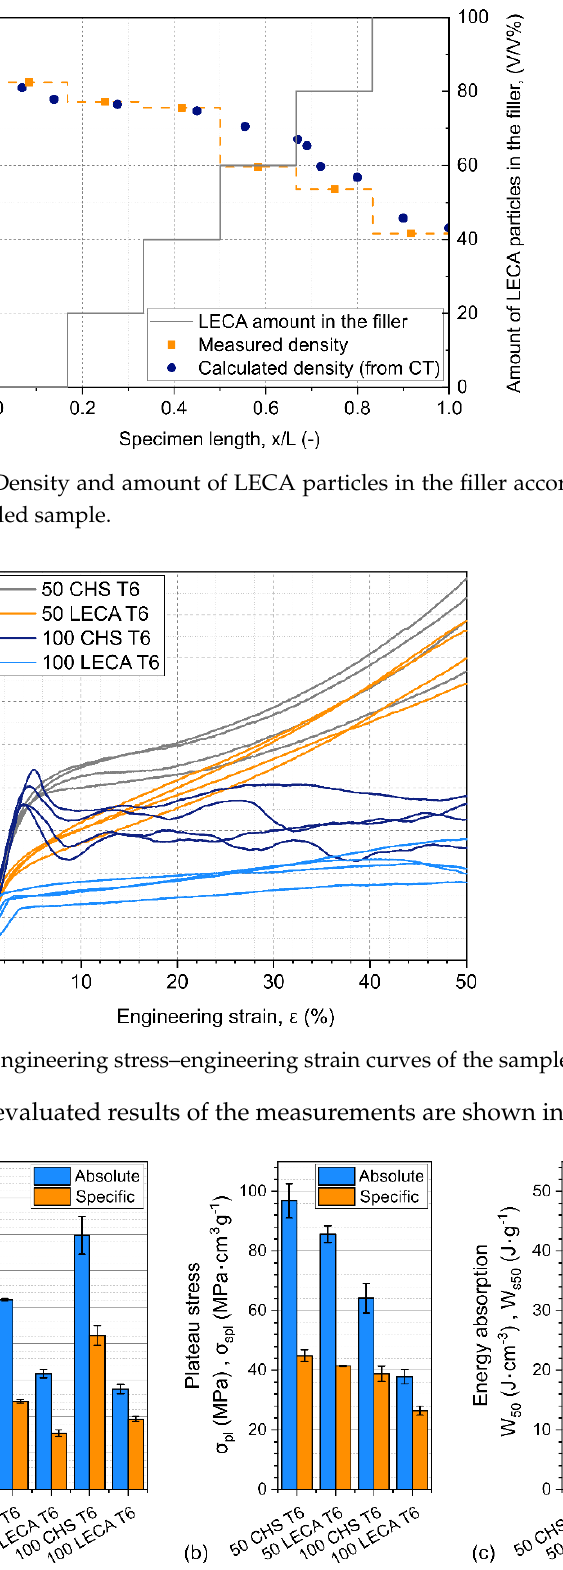
Figure 4. CT scan layers of half of the 0-100-0 LECA sample.